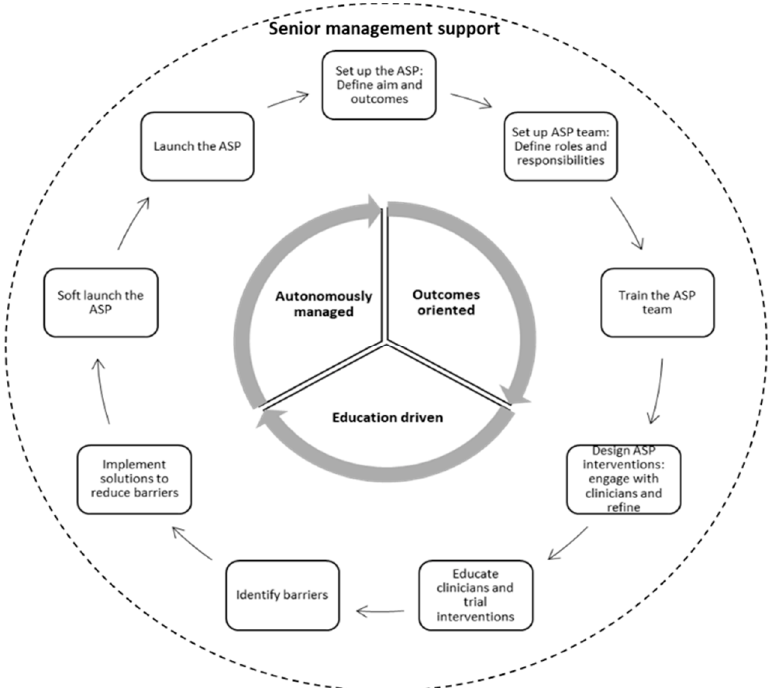
Figure 4. ASP implementation process